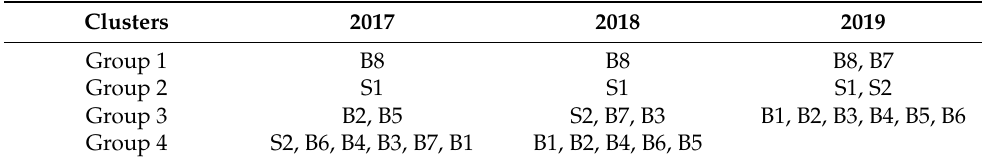
Table 3. Cluster structure in